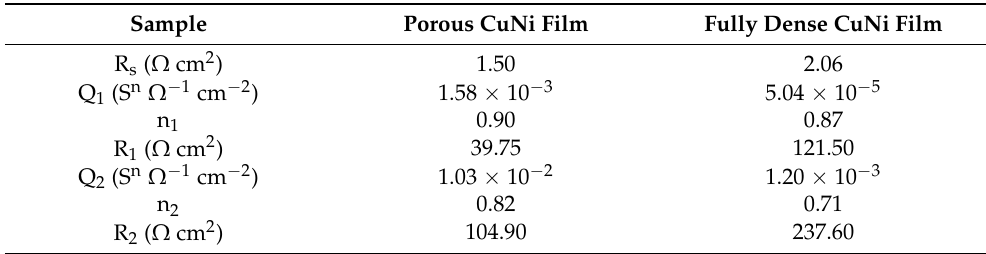
Table 2. Best-fit estimates of electric equivalent circuit parameters obtained from the impedance measurements of the porous and fully dense CuNi films in 1 mol/L KOH at 25 ◦ C. Sample Porous CuNi Film Fully Dense CuNi